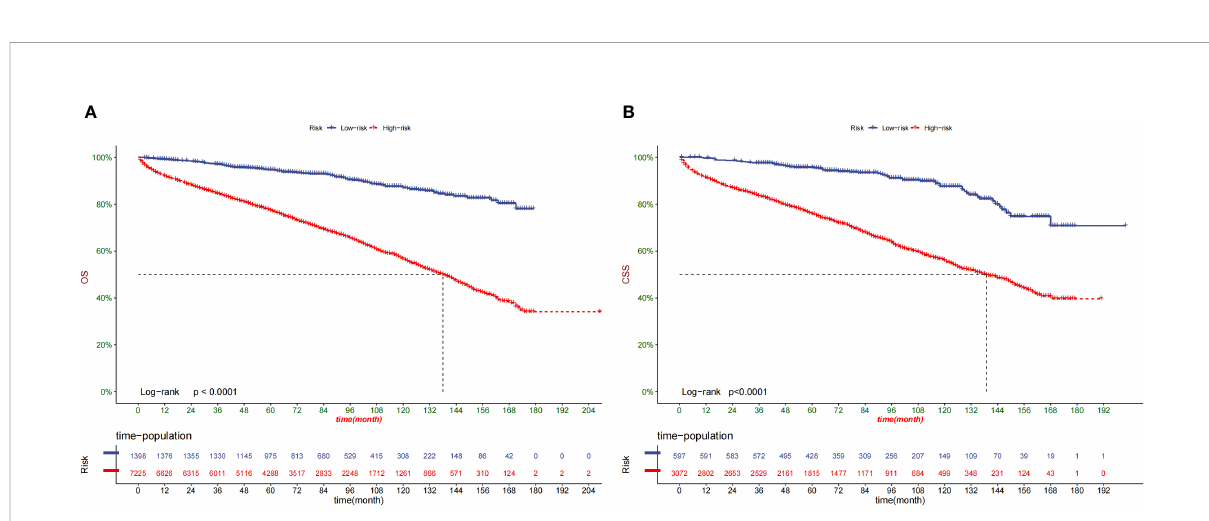
FIGURE 7 Kaplan – Meier curves of OS for patients in the low-, and high-risk groups in the training Cohort (A) and validation Cohort (B)